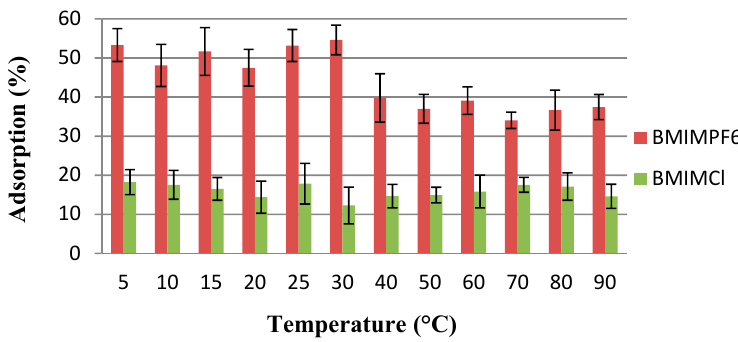
Figure 4. Influence of temperature on adsorption efficiency of BMIM PF 6 and BMIM Cl.